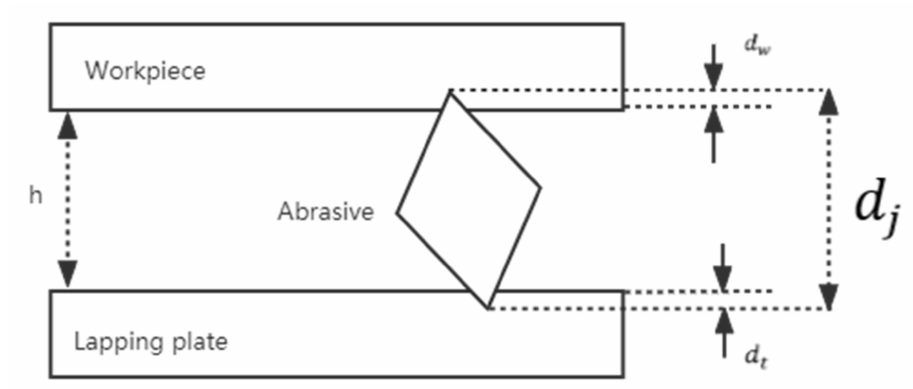
Figure 4. Analysis of the geometric relationship of the force on abrasive